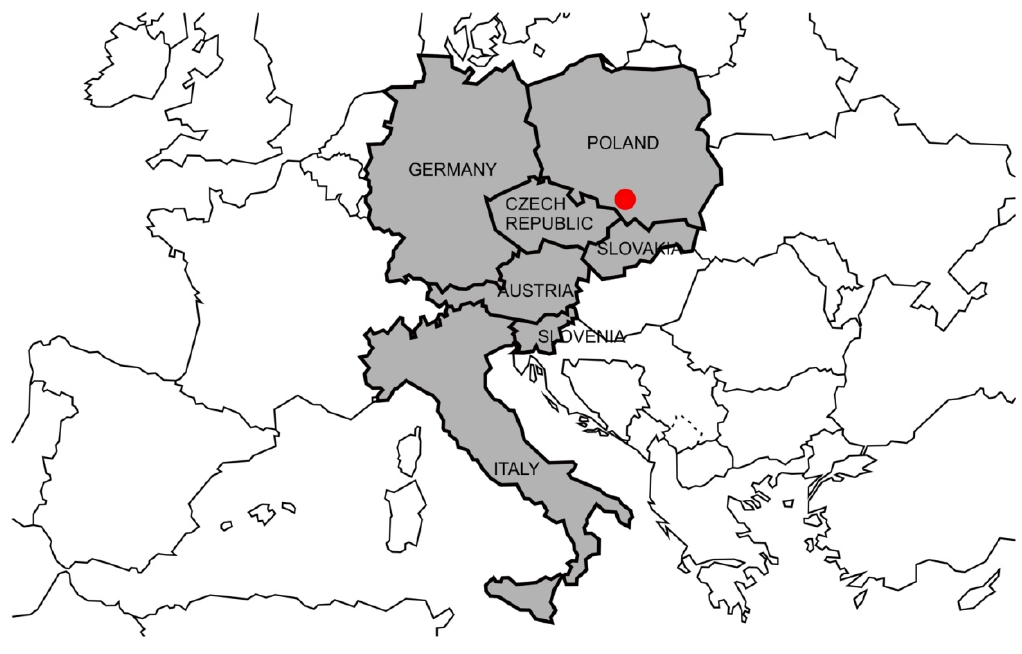
Figure 1. Partner countries of the LUMAT Program. Pilot project location—Ruda Ś l ą ska, Upper Silesia, Poland.